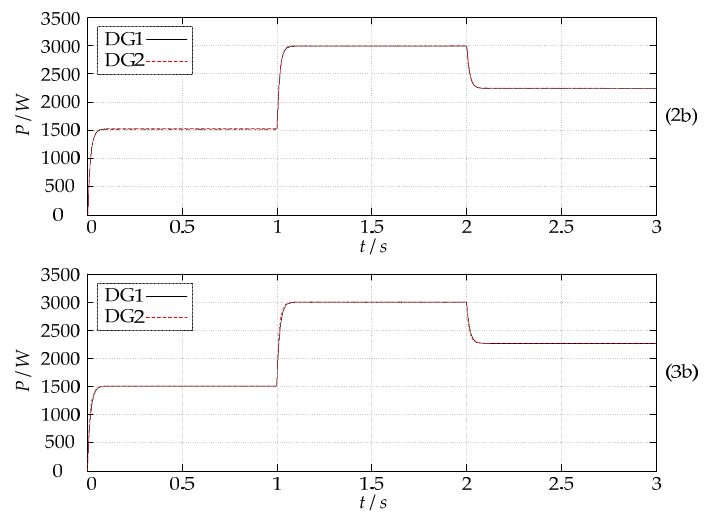
Figure 10. Simulation results of active power/DG voltage: method 1 (traditional method) using constant voltage amplitude reference; method 2 (proposed method) using CVAR; method 3 (proposed method) using improved active droop coefficient. ( 1a ) DG voltage in method 1; ( 2a ) DG voltage in method 2; ( 3a ) DG voltage in method 3; ( 1b ) DG active power output in method 1; ( 2b ) DG active power output in method 2; ( 3b ) DG active power output in method 3.